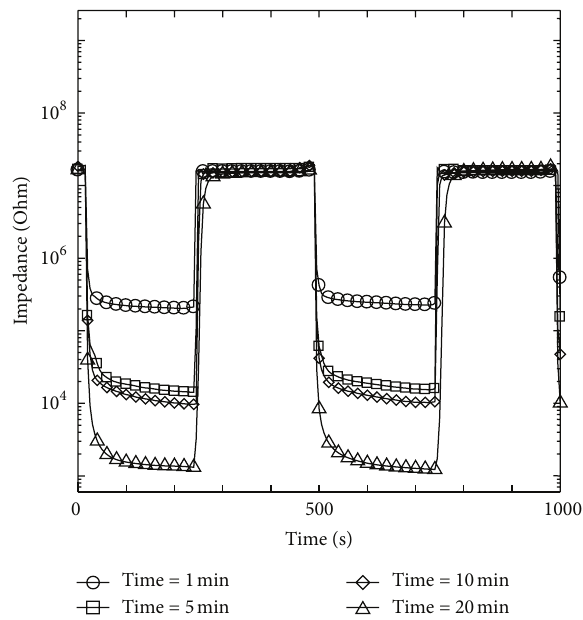
Figure 6: Response time of the Ag NPs humidity sensor at different deposition time under humidity cycling of 11%–93%–11%RH.